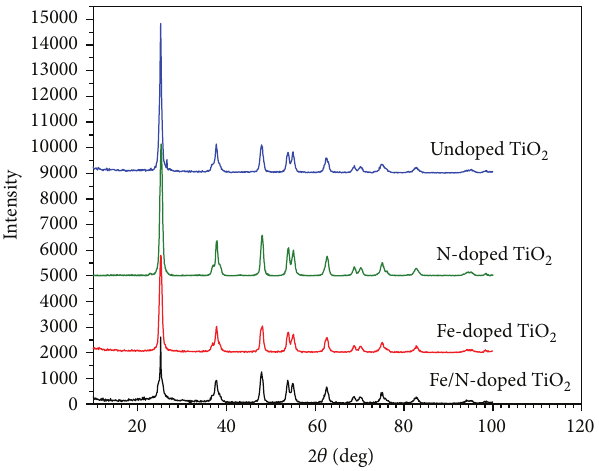
Figure 3: UV-Vis absorption